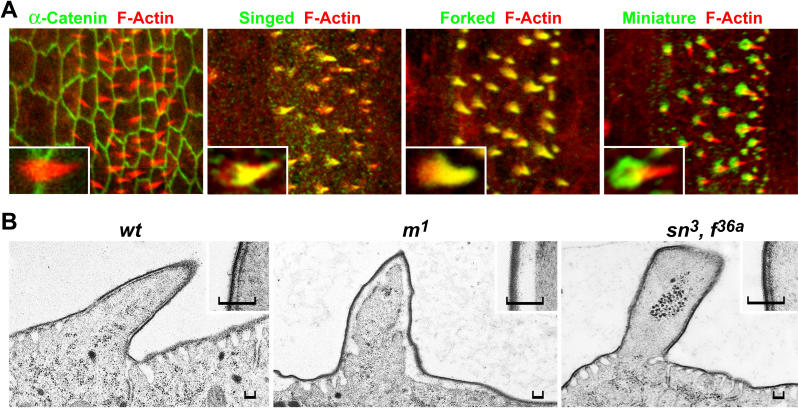

svb Target Genes Are Involved in Separate Features of Denticle Edification(A) Subcellular localization of Singed, Forked, and Miniature in the epidermis of stage 15 wild-type embryos. Distribution of α-catenin, a component of adherens junctions that underlines the cell contour, was observed in embryos expressing α-catenin-GFP driven by E22C-Gal4. Red indicates F-actin, and green indicates α-catenin, Singed, Forked, and Miniature.(B) Transmission electron microscopy analysis of denticle cells from wild-type (wt), m1, and sn3, f36a double mutant embryos. As in smooth cells, the flat region of the apical cell face organizes microvilli that contact cuticle layers only at the apex. In contrast, the plasma membrane is in close contact with cuticle along the entire wild-type denticle contour. Although the m1 mutation alters this membrane/cuticle contact, no defects are visible in sn3, f36a embryos. Close-up pictures show a region of the growing extension. Scale bar represents 0.25 μm.